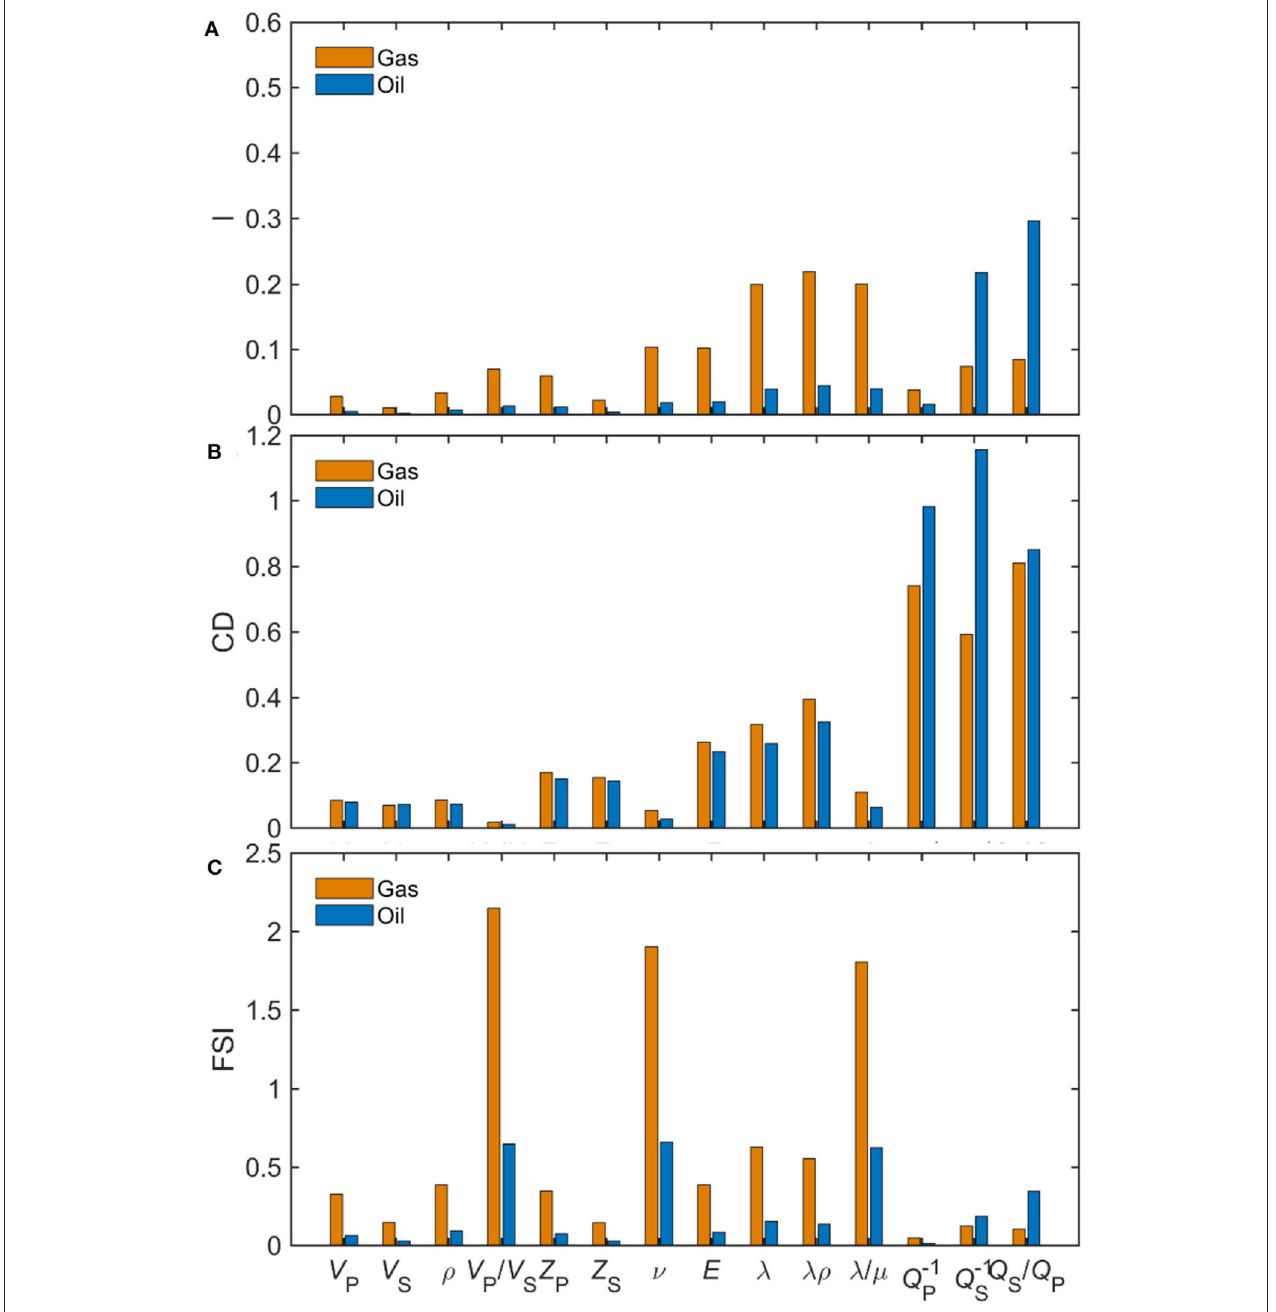
FIGURE 2 | (A) I, (B) CD, and (C) FSI for dolomites (see Figure 1 for the explanations).